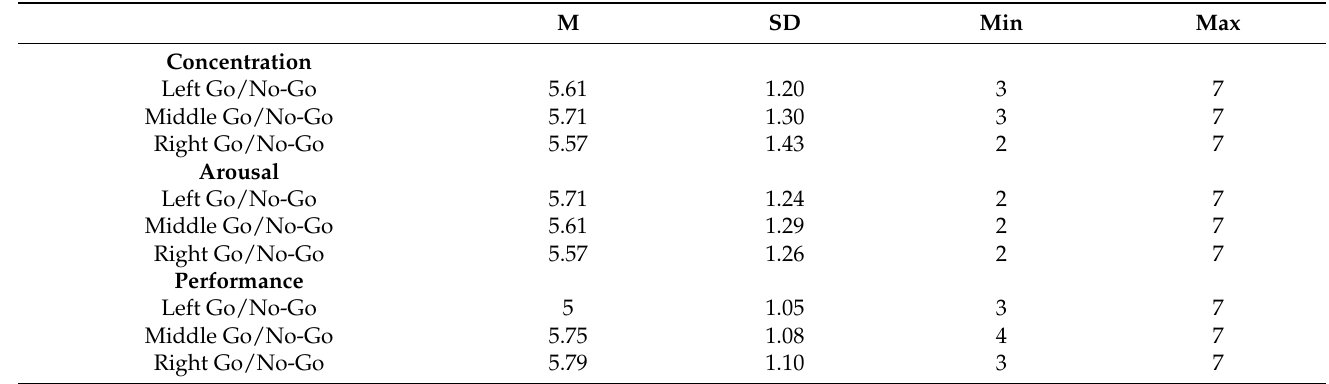
Table 4. Descriptive data for the 7-point Likert scale of self-reported levels of concentration, arousal and